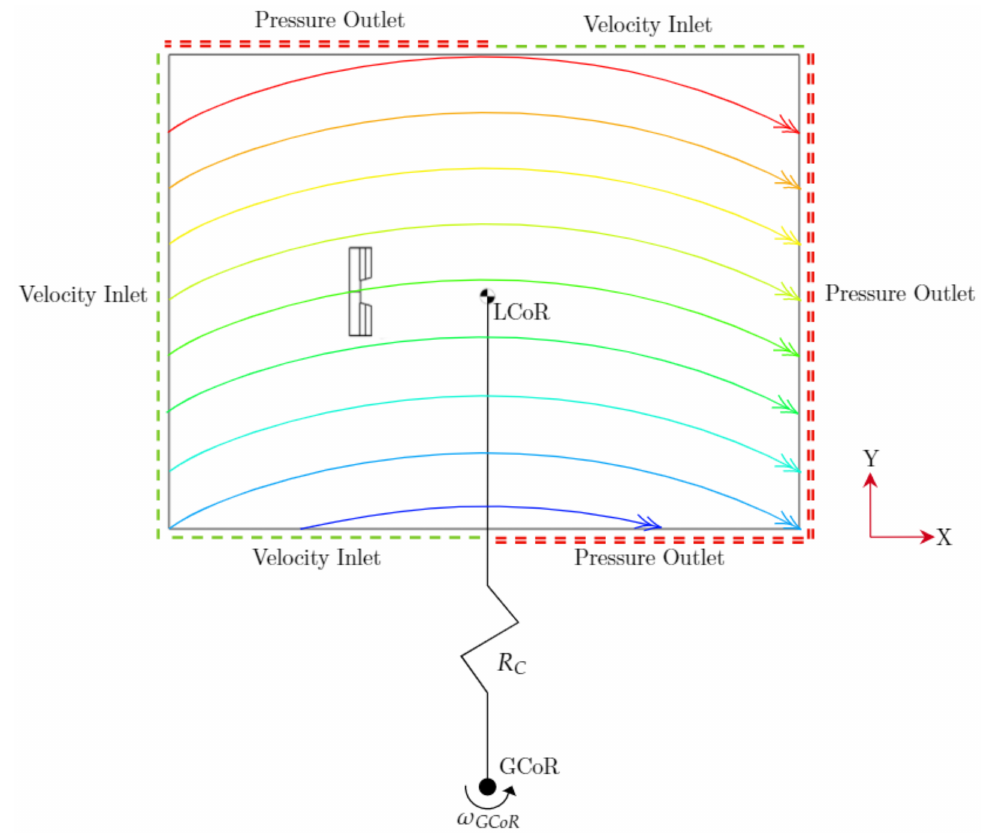
Figure 8. The boundary conditions for the cornering